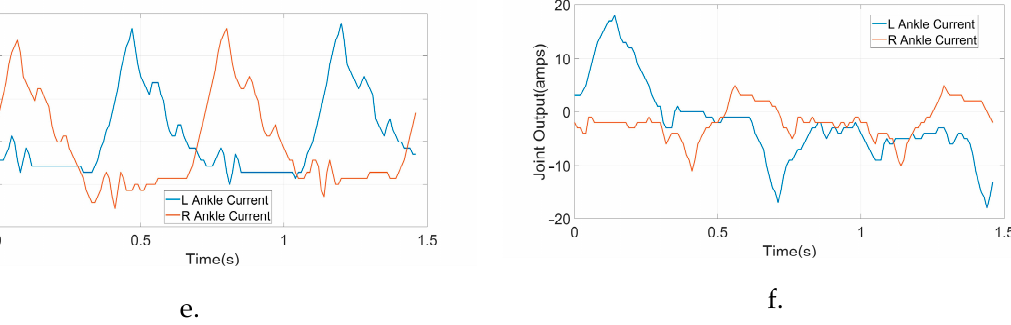
Figure 7. Feedback input trajectories of each active joint. ( a ) Roll and Yaw input of symmetric gait. ( b ) Roll and Yaw input of non-symmetric gait. ( c ) Pitch and Knee input of symmetric gait. ( d ) Pitch and Knee input of non-symmetric gait. ( e ) Ankle input of symmetric gait. ( f ) Ankle input of non-symmetric gait.